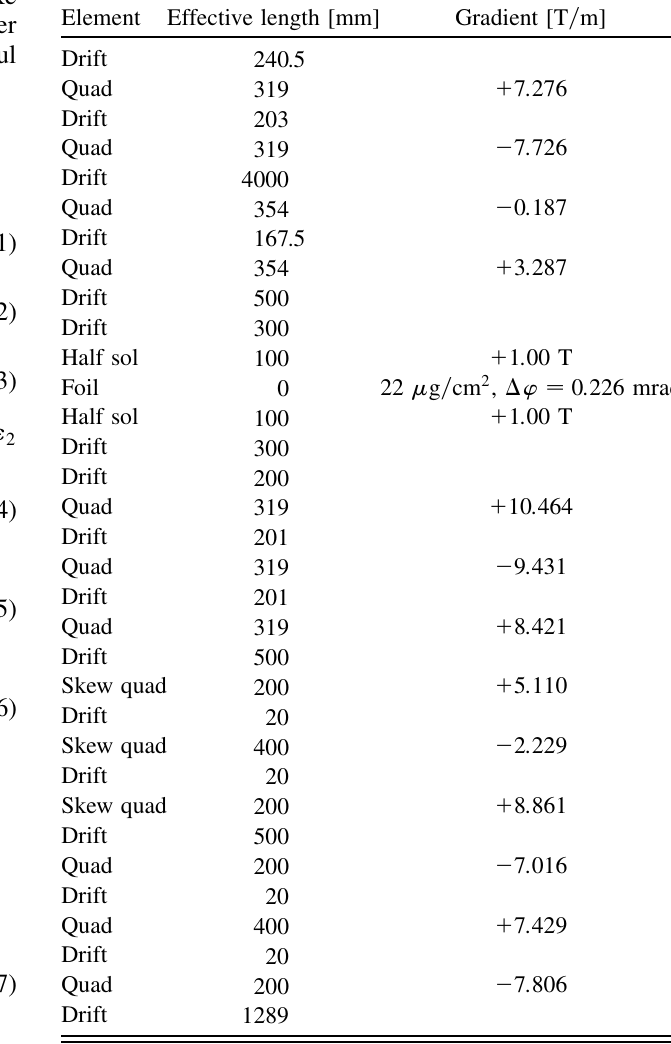
Table I. Positive gradient means horizontal focusing and a skew refers to a regular quadrupole rotated clockwise by TABLE I. The lattice of the EMTEX beam